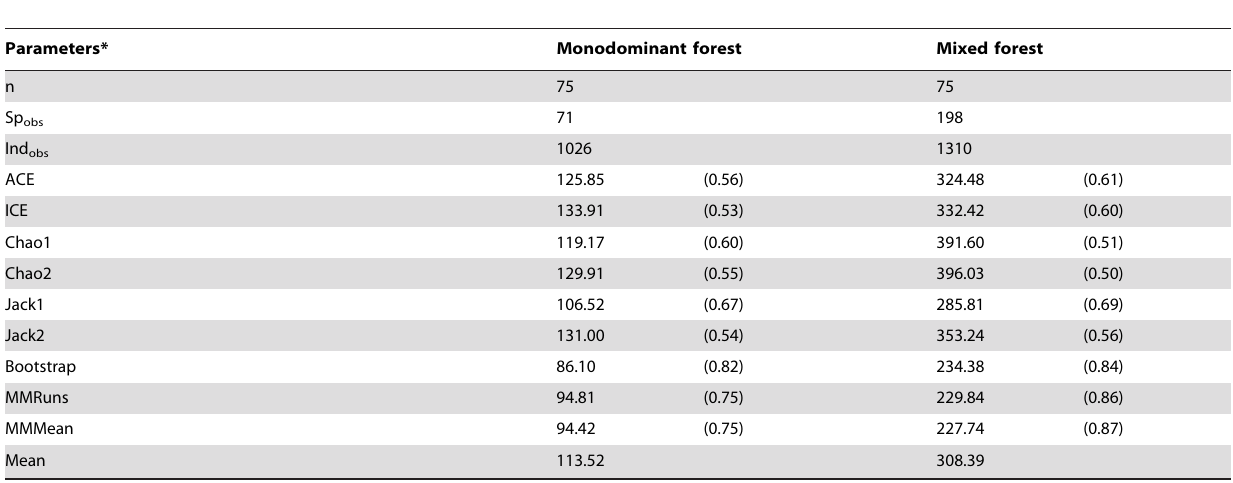
Table 1. Nonparametric species richness estimations of the monodominant Gilbertiodendron forest and the adjacent mixed forest.